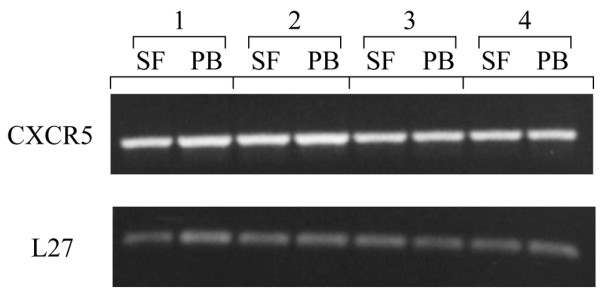
RT-PCR on monocytes/macrophages from peripheral blood (PB) and synovial fluid (SF). CXCR5 RT-PCR products were separated on 0.8% agarose gels and stained with ethidium bromide. The reactions were performed on four additional rheumatoid arthritis patients. The ribosomal RNA L27 was employed to normalize the amount of RNA used in each reaction.